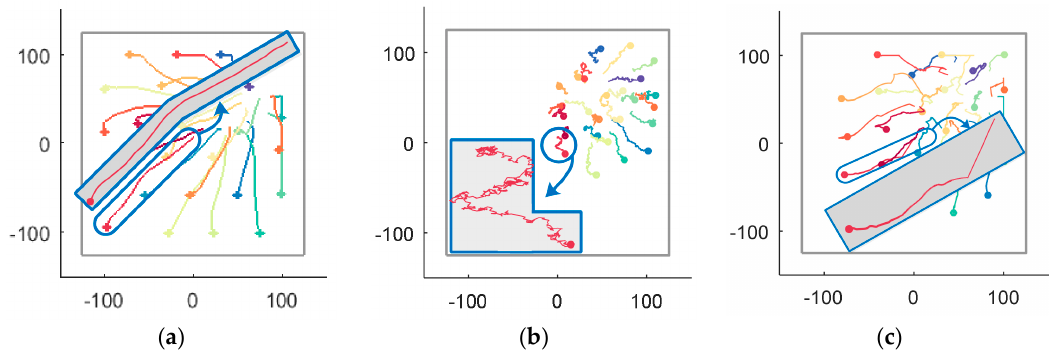
Figure 18. The recorded trajectories of UAVs generated by the simulation step k = 0 ∼ 574 by the RD, V-based and VFA methods. ( a ) The RD method’s trajectories; ( b ) The V-based method’s trajectories; ( c ) The VFA method’s trajectories.